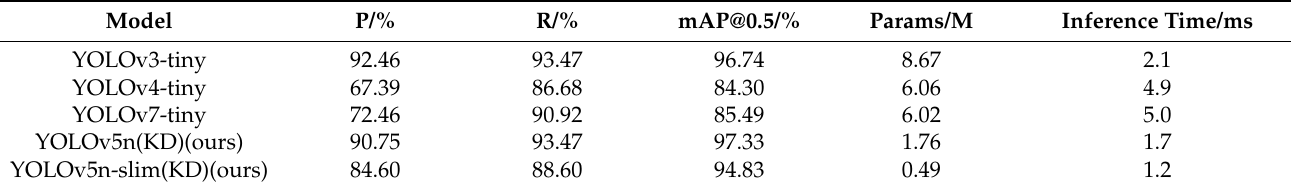
Table 6. Comparison of YOLO Lightweight Network Performance.